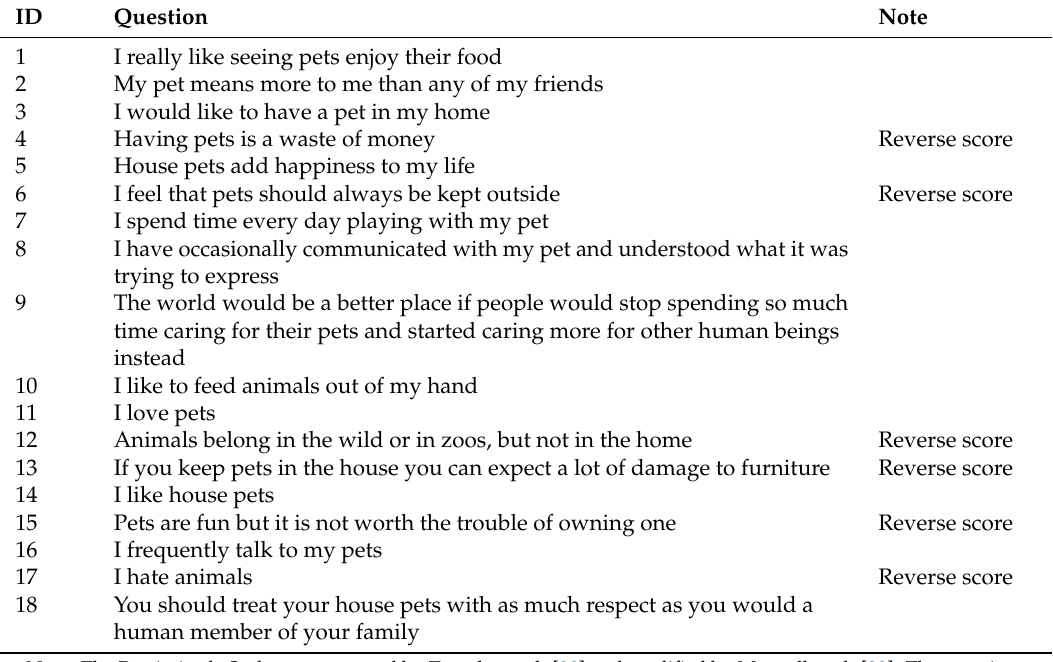
Table 2. The questions in the modified Pet Attitude